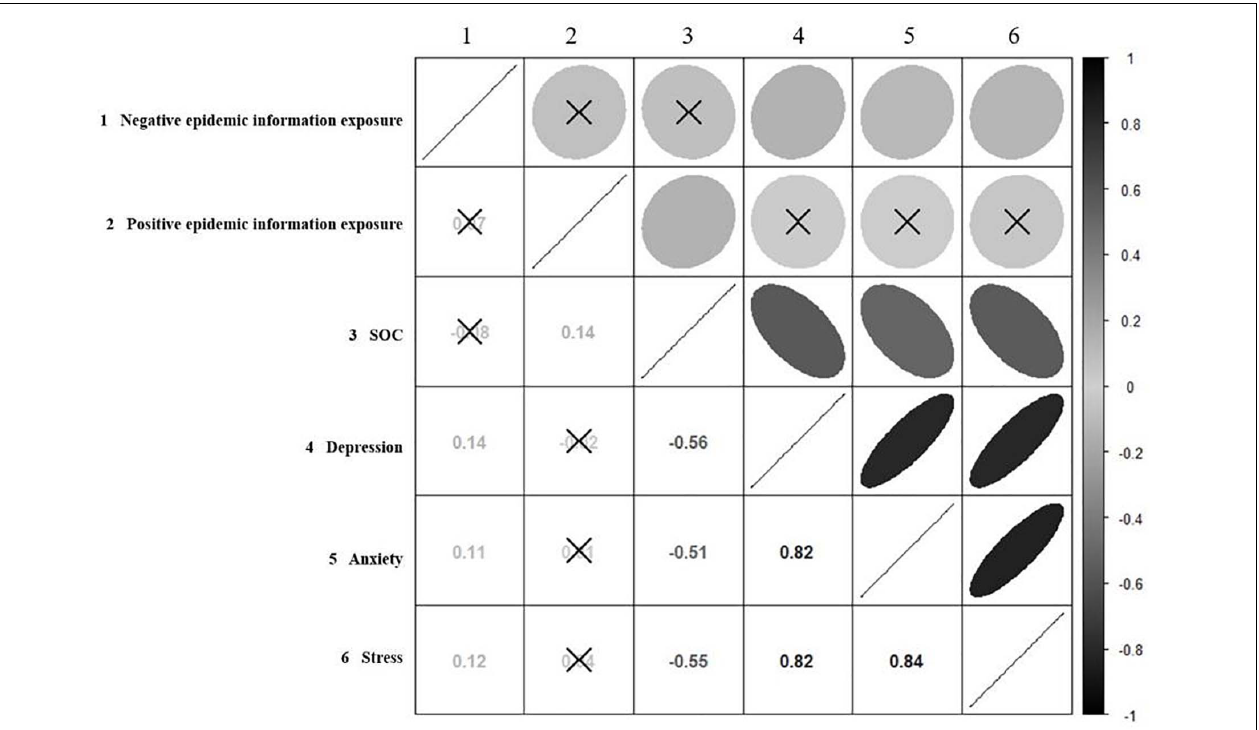
FIGURE 2 | Correlation matrix of variables used in the present study.The correlation coefficients for each pair of variables were shown with the numerical values and ellipses in the matrix. The gray scale indicates the correlation coefficients. Black crosses indicate that the correlation was not significant ( P >